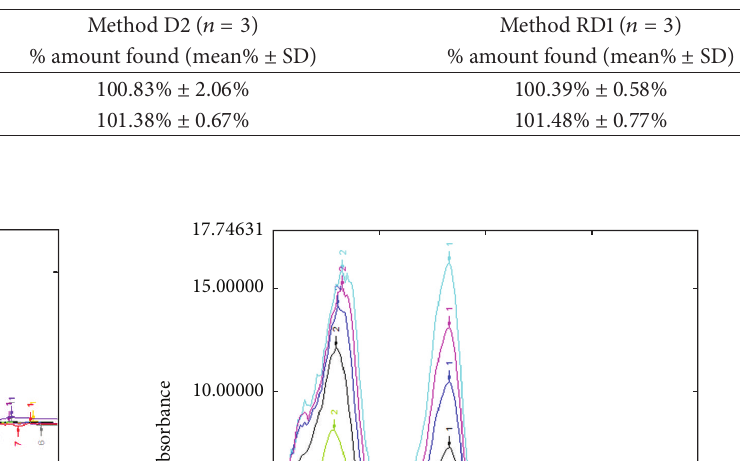
Table 2: Analysis of synthetic mixture.